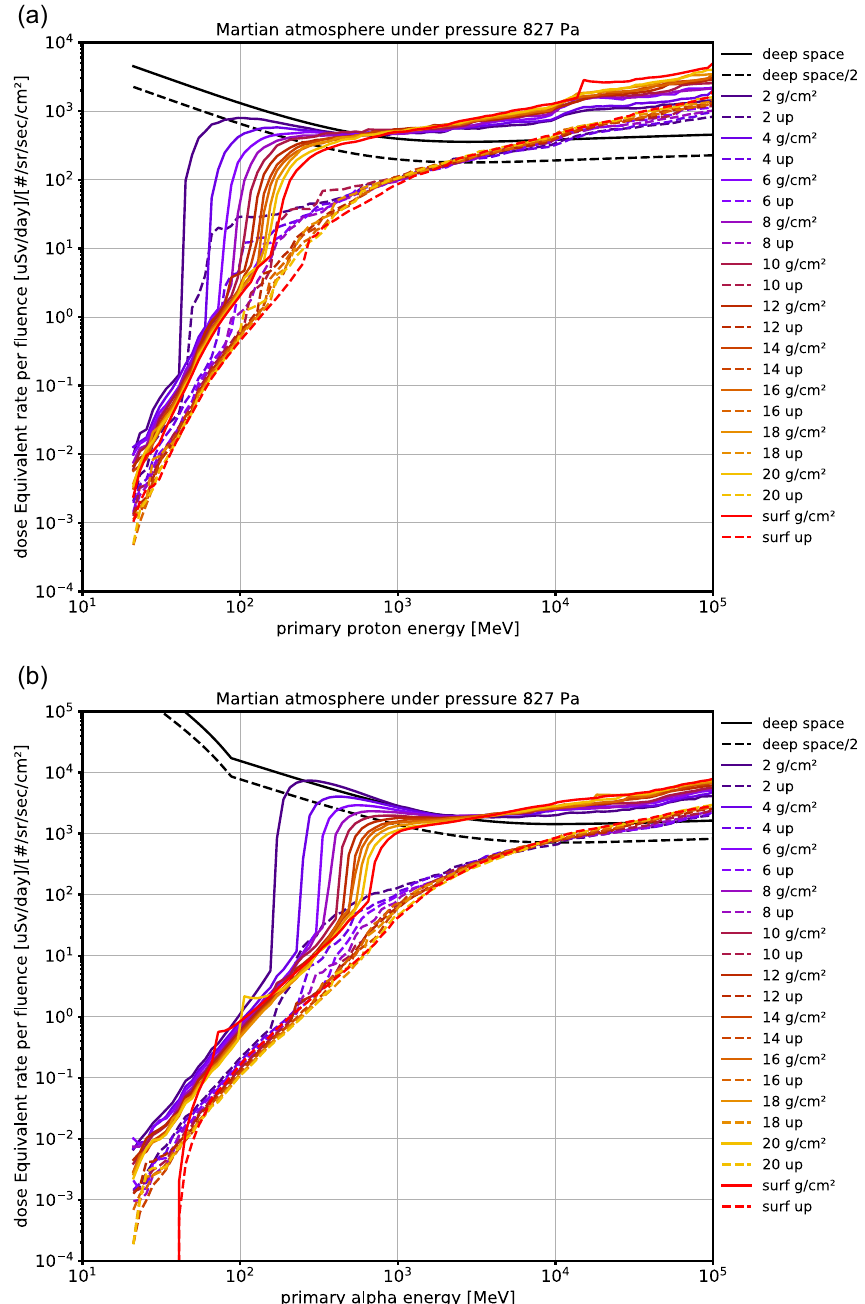
Fig. 4. Dose equivalent rate per primary fl ux function for protons (a) and 4 He ions (b) at different depth (2,4,6 ... 20 and surface) of the Martian atmosphere with a surface pressure of 827 Pa. Line colors and properties are set to be same as in Figure